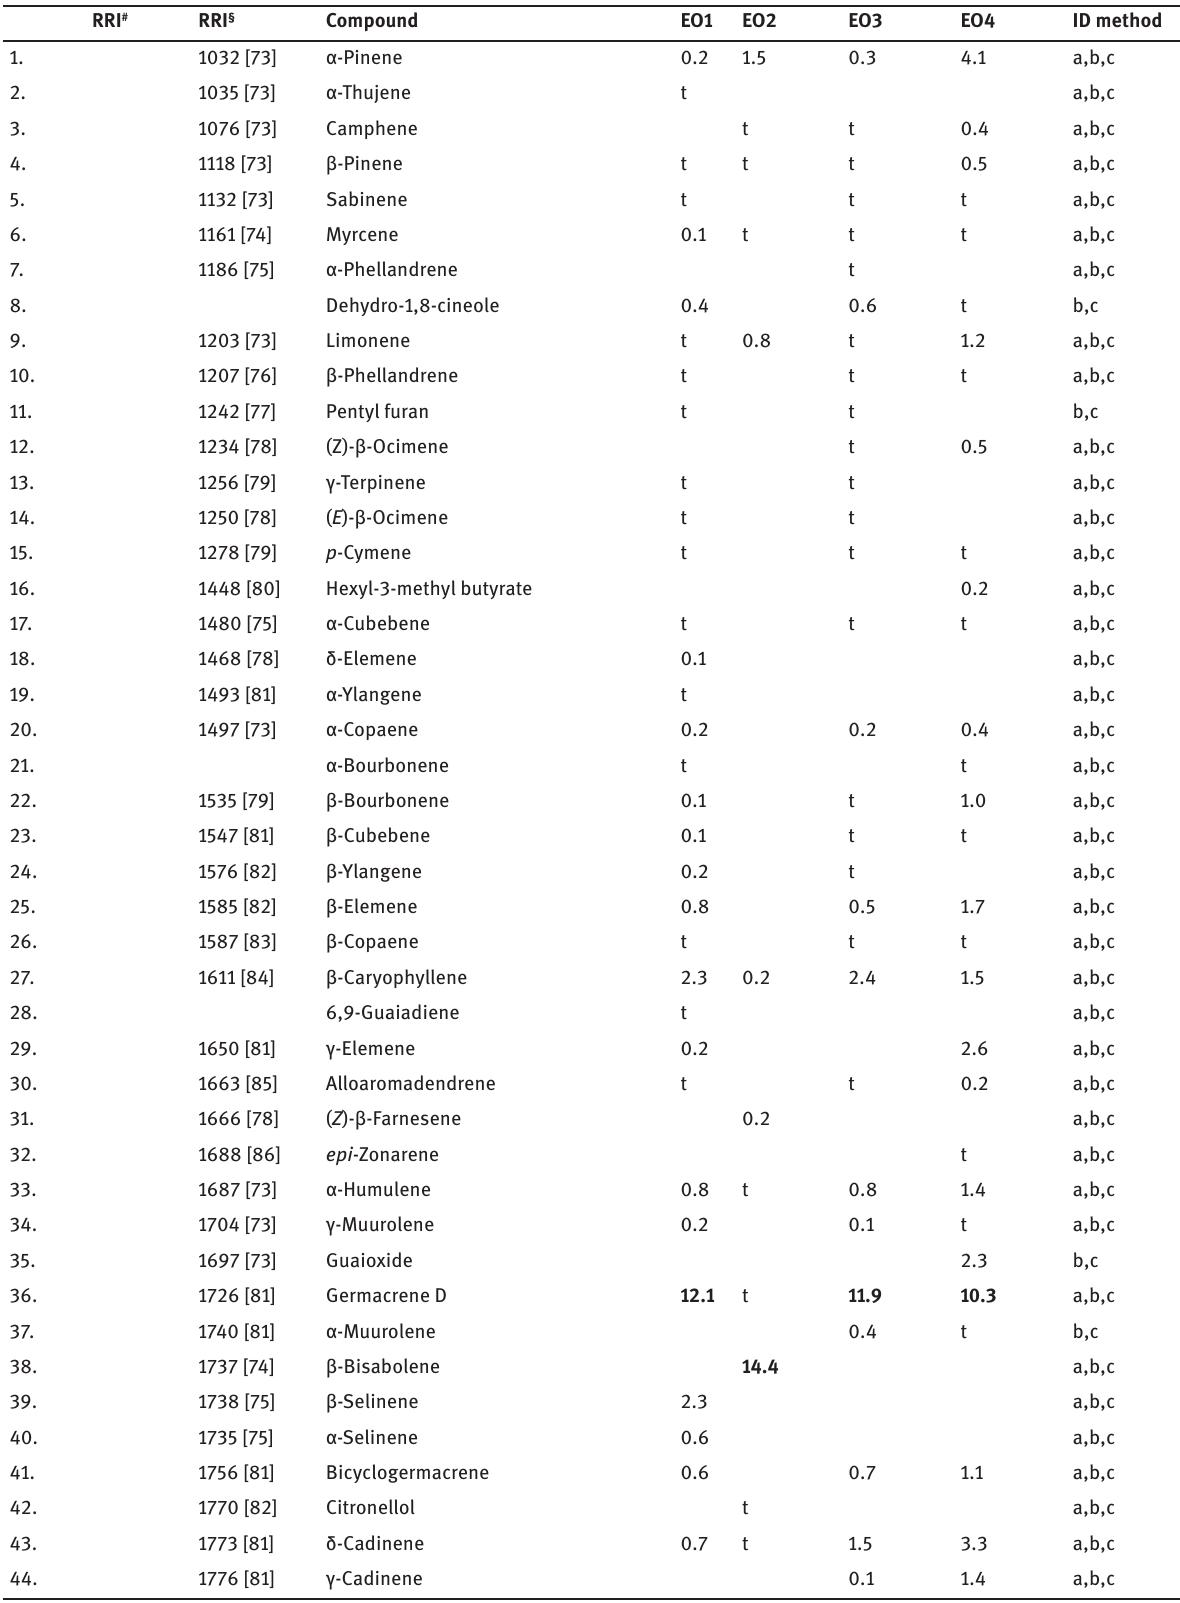
Table 4: Chemical composition of Prangos heyniae essential